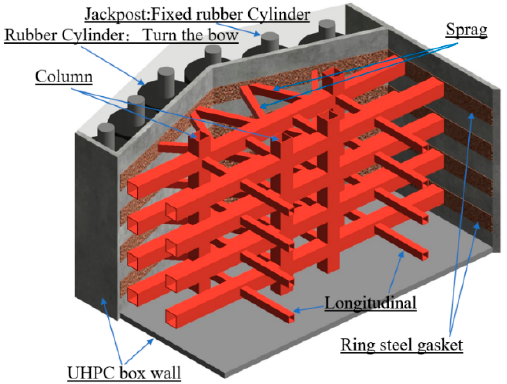
Figure 3. Internal structure of No.1 box.